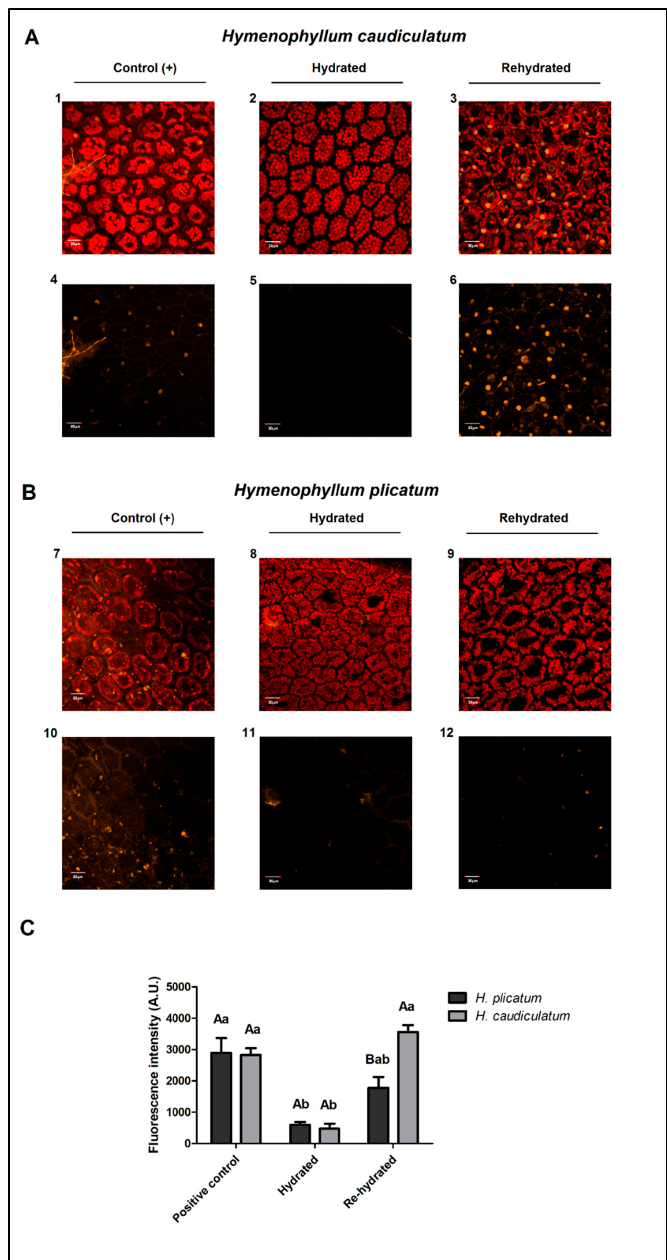
Figure 2. Changes in membrane integrity during a desiccation–rehydration cycle in two filmy fern species with contrasting desiccation tolerance: ( A ) Hymenophyllum caudiculatum , less desiccation tolerant, ( B ) Hymenophyllum plicatum , more desiccation tolerant, ( C ) Fluorescence intensity in arbitrary units for propidium iodide channel. Hydrated and rehydrated fronds of both species were stained with propidium iodide for 30 min and visualized by confocal laser scanning microscopy. Bars represent the mean ± SE of 5 areas of interest within each representative image of propidium iodide fluorescence. Lowercase letters indicate intraspecific di ff erences among the three stages of water status, while uppercase letters indicate interspecific di ff erences at each water status (Holm-Sidak method, p ≤ 0.01). Panels A2 , A3 and panels B8 , B9 are maximal projection of optical z-stacks of merged signal from propidium iodide fluorescence (orange) and internal control of chlorophyll fluorescence (red). Panels A5 , A6 and B11 , B12 , are maximal projections of optical z-stacks of propidium iodide fluorescence (orange). Panels A1 – A4 and B7 – B10 are from the positive stained control of permeabilized cells (cellulase enzyme plus PI in DMSO). Scale bars: 30 µ